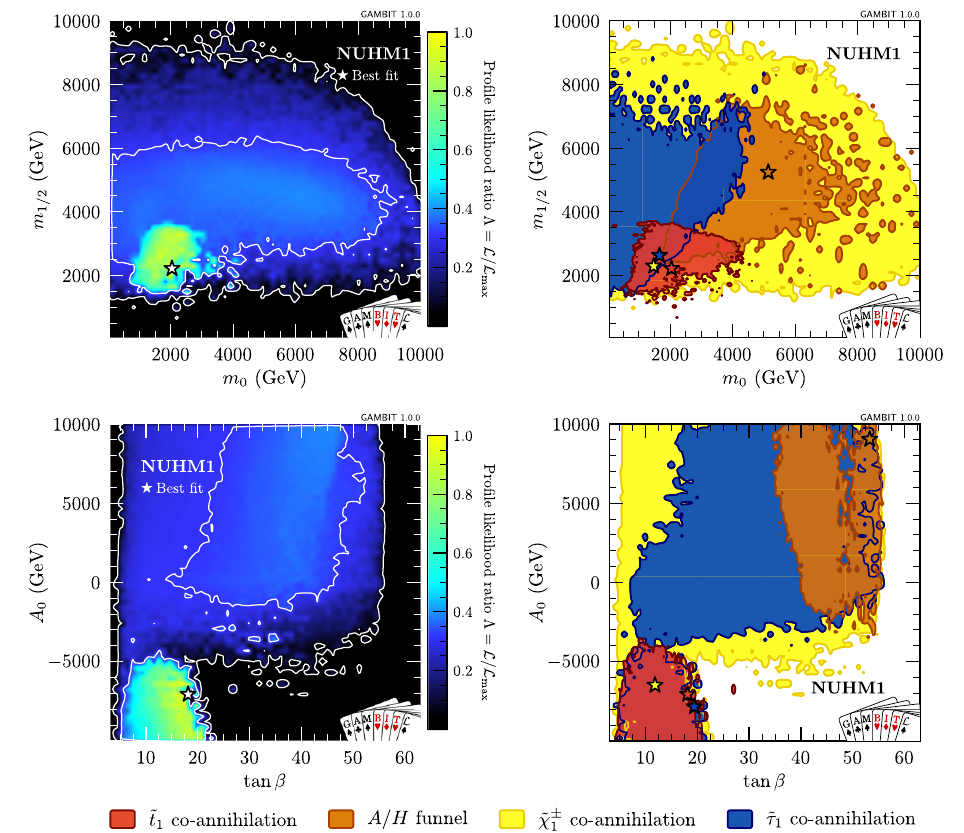
Fig. 5 Left:ProfilelikelihoodratiointheplanesoftheNUHM1param- eters m 0 and m 1 / 2 (top), and tan β and A 0 (bottom). Explicit contour lines for 68% and 95% CL are drawn in white and the best fit point is